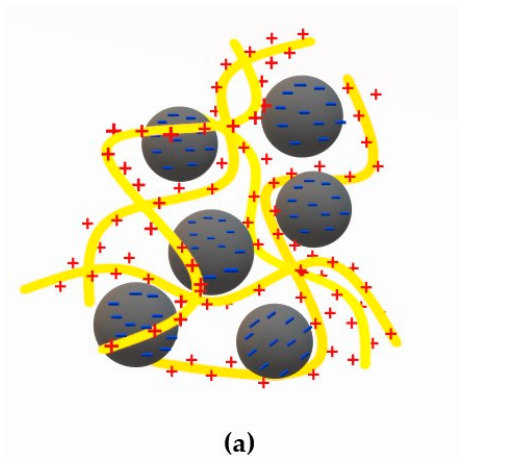
e ff ective for low molecular weight polymers ( < 10 5 Da) able to adsorb and neutralize the particles suspended in water [5,37,38].